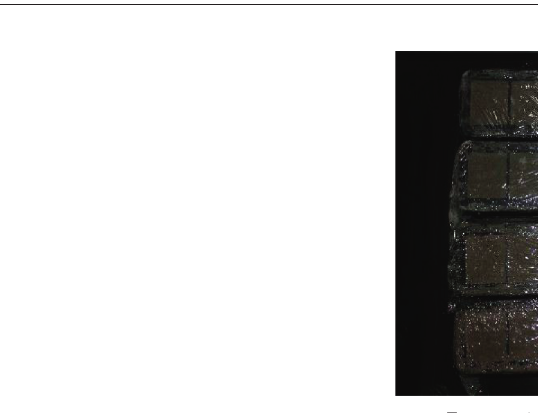
Figure 6: Cement mortar samples. Table 3: Mortar mix proportion of each group.